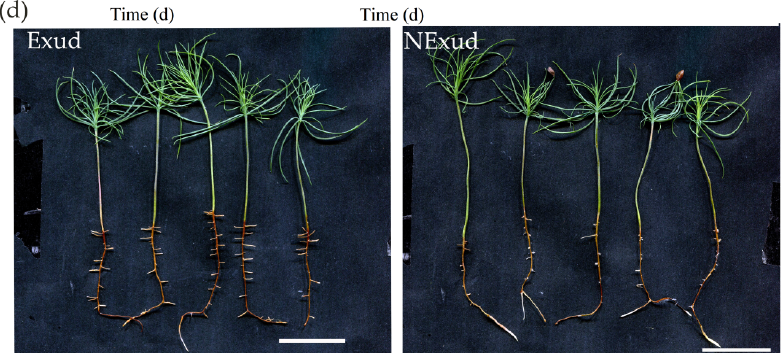
Figure 1. Effects of volatile organic compounds (VOCs) and exudates released by Suillus bovinus on the growth of Pinus massoniana . ( a ) Number of root branches, root length, and fresh weight of P. massoniana seedlings treated with VOCs and without VOCs (NVOC), n = 15; ( b ) P. massoniana seedlings subjected to VOC (28 d) and NVOC (28 d) treatments, scale bars = 2 cm; ( c ) root branches, root length, and fresh weight of P. massoniana seedlings subjected to the exudate (Exud) (28 d) and non-exudate (NExud) (28 d) treatments, n = 20; ( d ) P. massoniana seedlings subjected to Exud (28 d) and NExud (28 d) treatments, scale bars = 2 and 3 cm. ** p < 0.01; * p < 0.05. Bars represent mean values ± the SE. Different letters above bars indicate significant differences between treatments. However, S. bovinus VOCs and exudates had the opposite effects on A. thaliana growth. Although S. bovinus VOCs promoted A. thaliana root branching, they inhibited the elonga- tion of the taproot (Figure 2a,b), and S. bovinus exudates inhibited both the shoot and root growth of A. thaliana (Figure 2c,d).